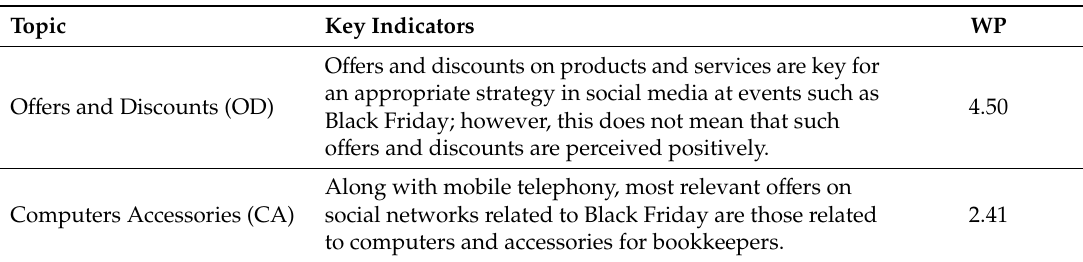
Table 7. TA indicators analysis of neutral